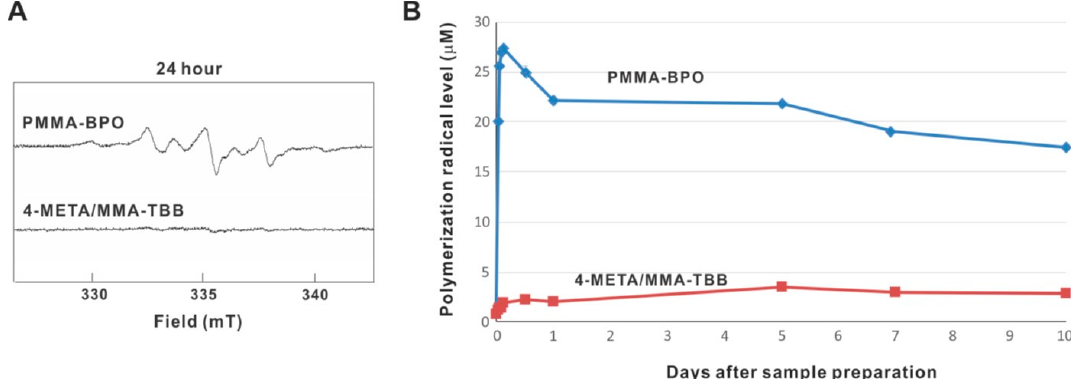
Figure 11. Free radical generation in polymerizing two different materials evaluated by electron spin resonance spectroscopy (ESR). ( A ) ESR spectrums recorded 24 h after mixing materials. ( B ) The time course of free radical production up to 10 days for each material.